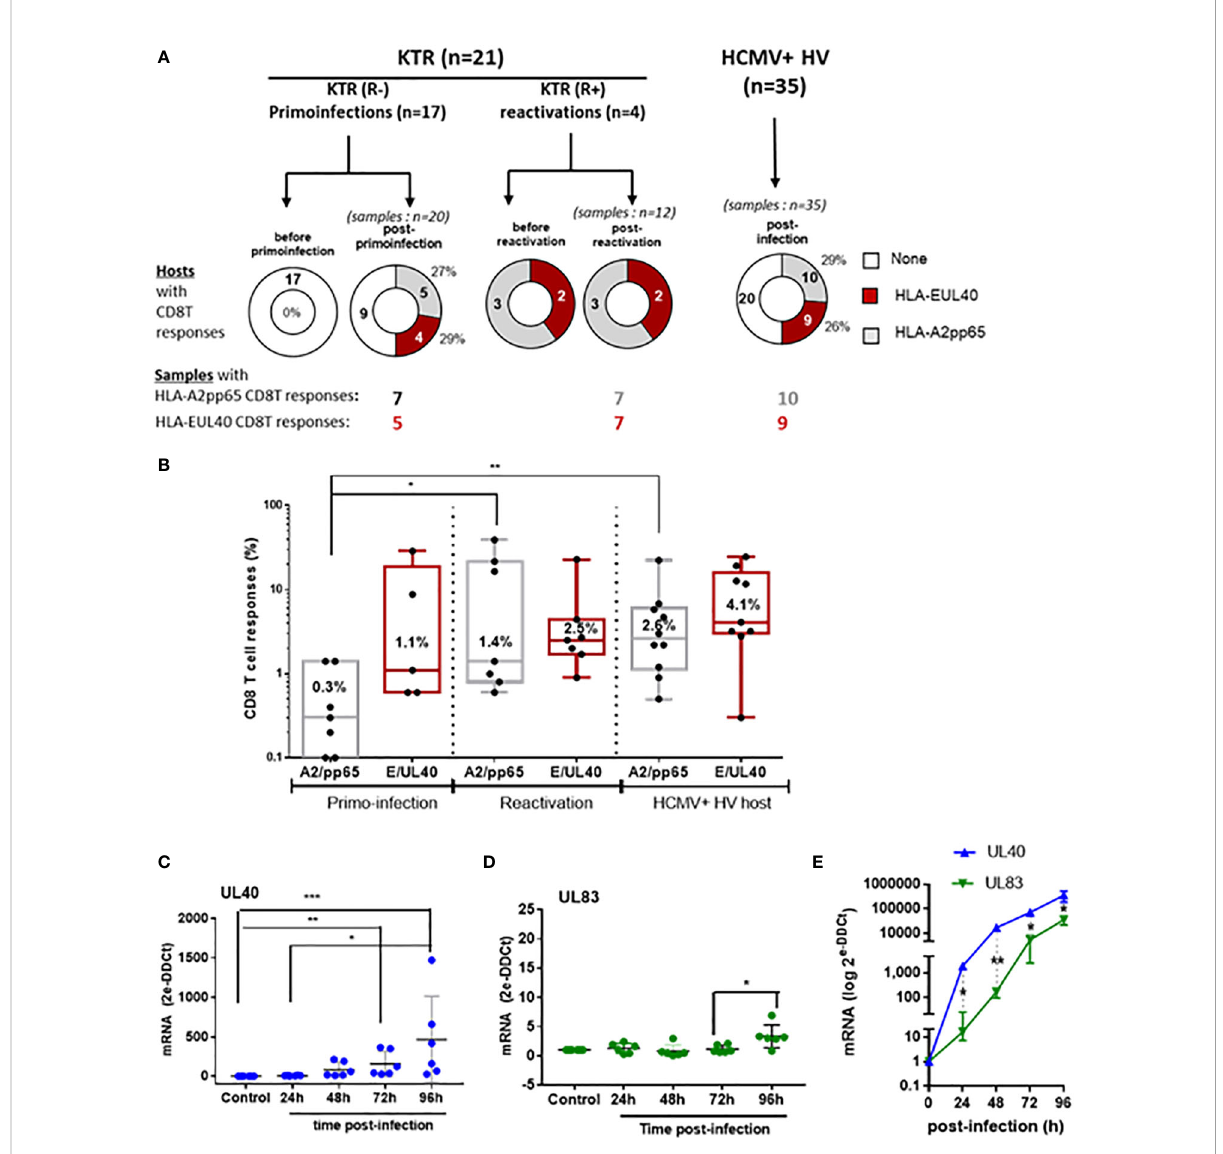
FIGURE 1 Detection and quanti fi cation of HCMV-speci fi c CD8Tcell responses in KTR and HV and time course analysis of viral UL40 and UL83 (pp65) post- infection. (A) Donut charts showing the numberof hosts with HCMV-speci fi c CD8Tcell responses (HLA-E UL40, HLA-A2 pp65 , none) including KTR before and after a primary infection (R - ), virus reactivation (R + ) and in HCMV+ healthy controls (HV). The number of samples containing the differents HCMV-speci fi c CD8T responses in the groups are indicated. (B) Box plots with median and interquartile values of the percentages of HCMV-speci fi c CD8Tcell responses (HLA-E UL40, HLA-A2 pp65 ) detected in blood among total CD8Tcells in samples from KTR after a HCMV primary infection (7 A2pp65 responses and 5 EUL40 responses), a reactivation (7 A2pp65 responses and 7 EUL40 responses), and in HCMV + HV (10 A2pp65 responses and 9 EUL40 responses). Each point corresponds to an individual CD8Tcell response. (C – E) Quantitative RT-PCR analysis of viral mRNA levels for UL40 and UL83/pp65 in HCMV-infected primary endothelial cells (n=5) (C, D) . Each point corresponds to an independant endothelial cell culture. (E) Quantitative RT-PCR analysis of viral mRNA levels for UL40 and UL83/pp65 in HCMV-infected MRC5 cells. Controls are uninfected cells. Results are medians from 5 independent endothelial cell cultures (C, D) or means ± SD from triplicate experiments for MRC5 cells (E) and are expressed as 2- DD Ct values normalized to the RPLP0 housekeeping gene. Statistical analysis was performed by Mann-Whitney U -test. P values: * for p < 0.05, ** for p<0.01 and *** for